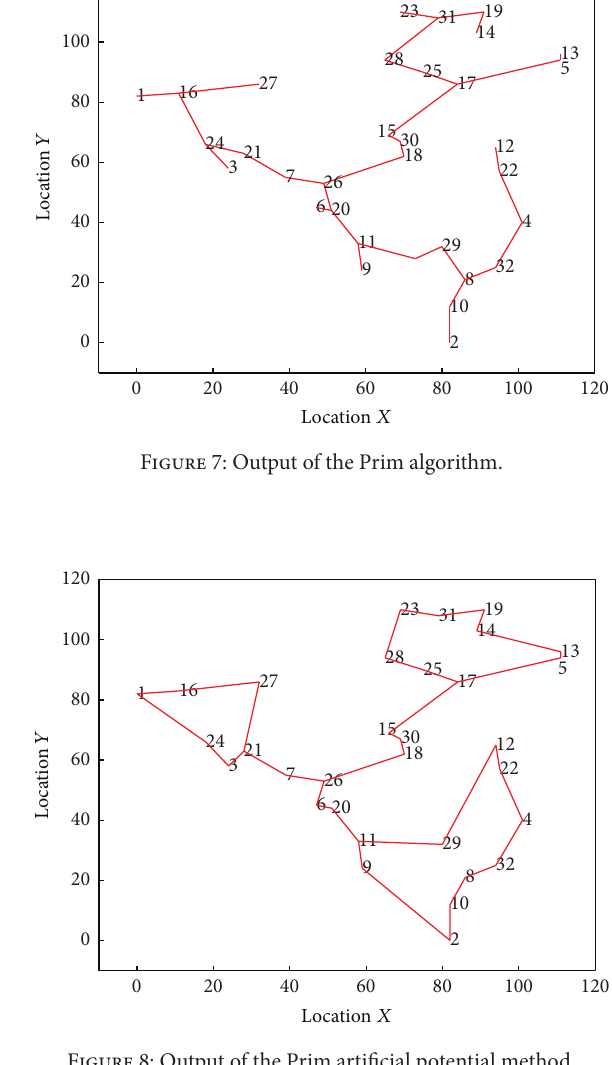
Figure 8: Output of the Prim artificial potential method.